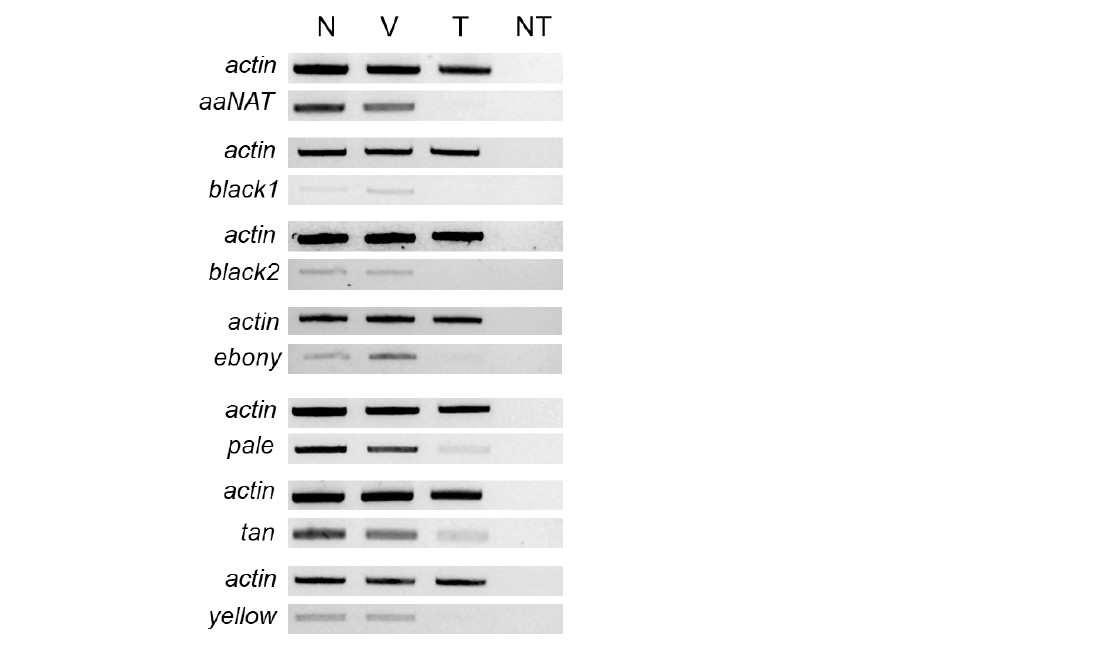
Figure 5. RT-PCR confirmation of target transcript knockdown by dsRNA-mediated RNAi. Products correspond to ~500-bp fragments of the transcripts of interest amplified from single adults at 7 days post-injection. Gels shown are representative of results obtained across five replicates. Abbreviations are: N (noninjected); V ( venus dsRNA injected); T (target dsRNA injected); NT (no template).